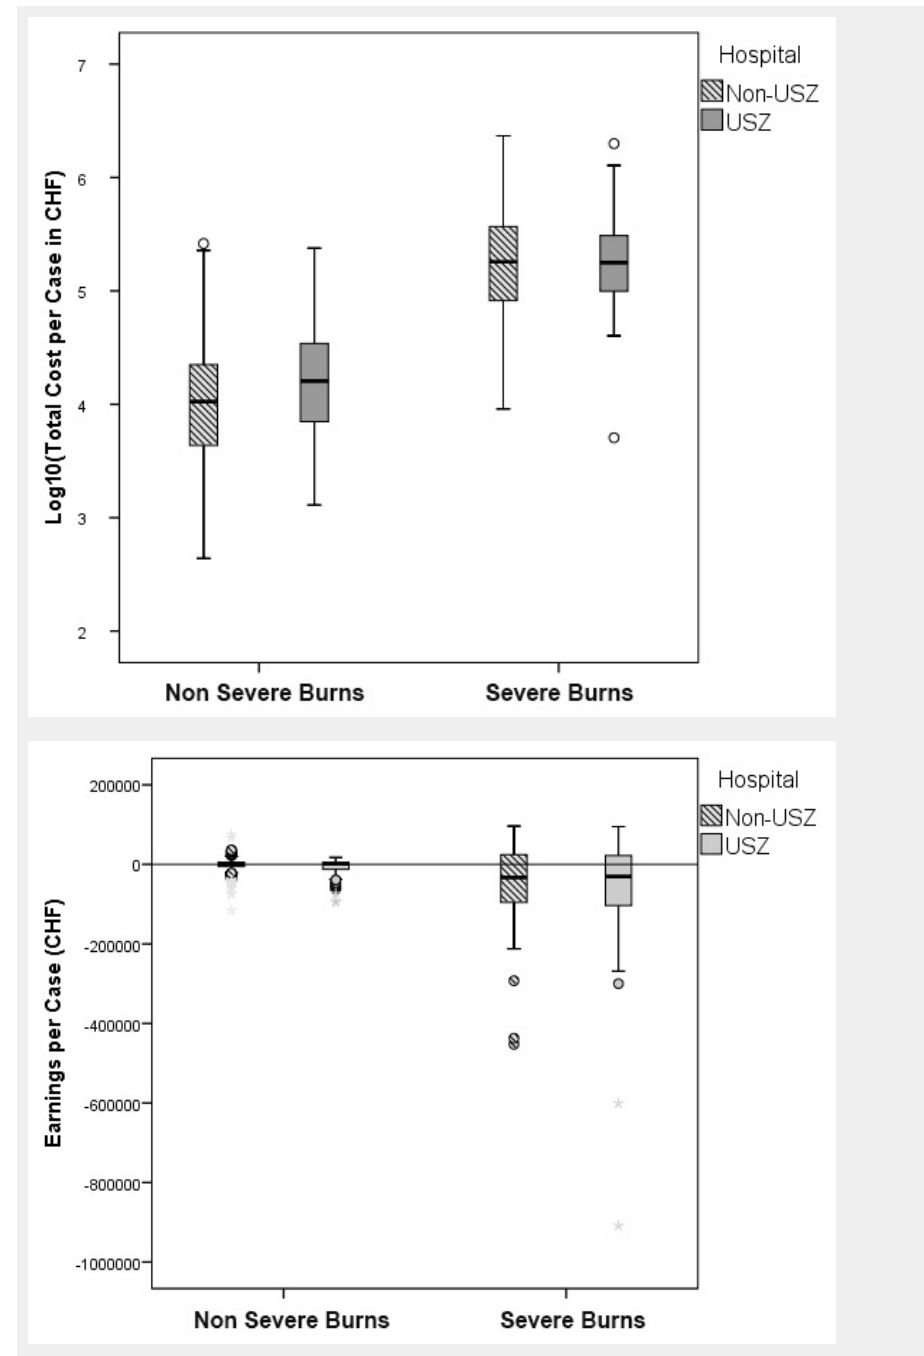
Figure 3 Distribution of total costs per case (fig. 3A) and total earnings per case (fig. 3B) for severe and nonsevere burns. A decadic logarithmic transformation of the cost function was performed to allow for easier analysis. The y-axis was limited to –1 000 000 CHF, hence one severe burn case (earnings of –1 324 732 CHF) is not visible. Study population: discharges from our hospital (n = 268) and all other Swiss university hospitals (n = 560). Severe burns (n = 109, of which n = 56 from our hospital and n = 53 from the four other university hospitals) and nonsevere burns (n = 719, n = 212 from our hospital and n = 507 from the four other university hospitals). Our hospital = USZ, the four other university hospitals =: Non-USZ. The upper and lower bounds of the boxes denote the upper and lower quartile respectively, with the broad line in the box denoting the median. Whiskers were defined by 1.5x interquartile range (IQR). Outliers were defined as either <1.5 x IQR of the first quartile or >1.5 x IQR of the third quartile. Outliers are represented as circles or asterisks, where asterisks denote extreme values (<3 x IQR of the first quartile or >3 x IQR of the third